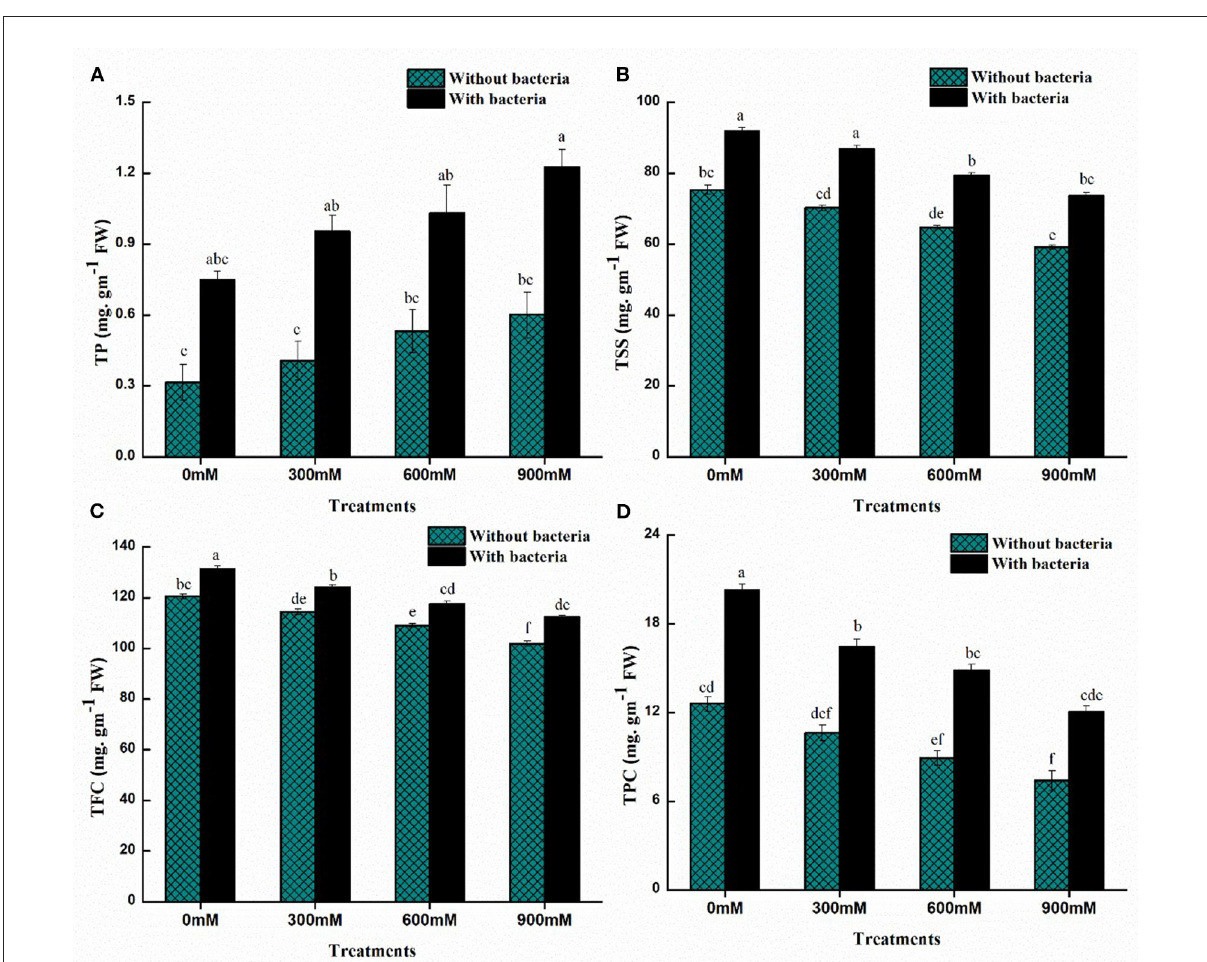
FIGURE5 Effects of Bacillus thuringiensis PM25 on (A) Total soluble sugars (B) Protein content (C) Flavonoid content (D) Phenolic content. Bars sharing different letter (s) for each parameter are significantly different from each other according to the LSD test ( p ≤ 0.05). All the data represented are the average of three replications ( n = 3). Error bars represent the standard errors (SE) of three replicates.